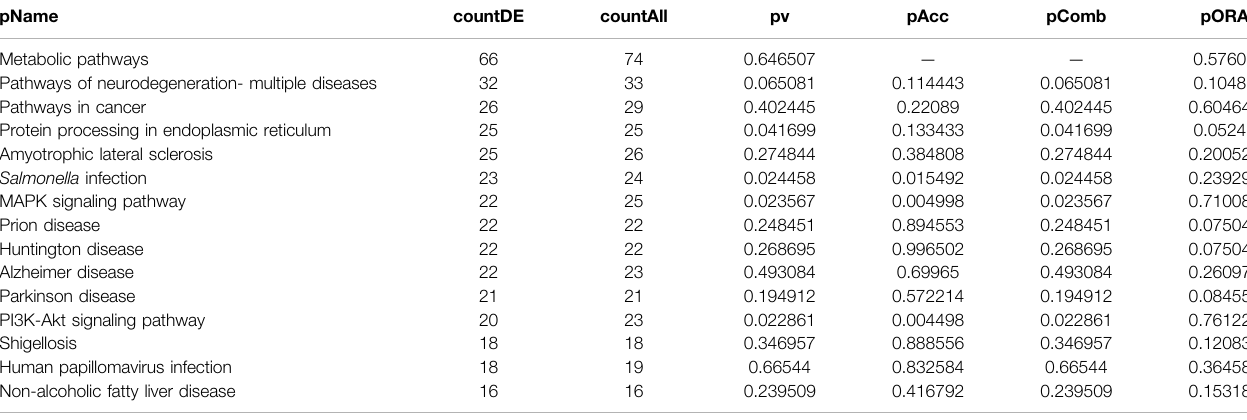
TABLE 2 | Top 15 pathways ranked based on their associated differentially expressed genes derived from astrocytes based on the comparison AD00203 (disease) vs. AD00201 (control). pName